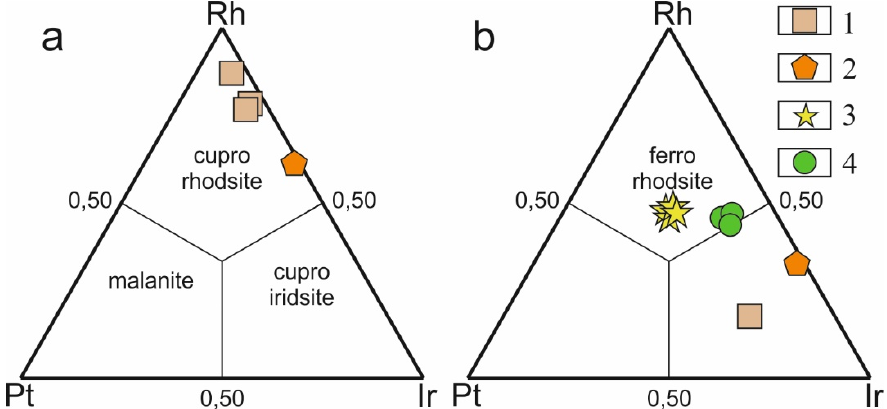
Figure 14. The composition (at. %) of Cu bearing ( a ) and Fe bearing ( b ) Pt-Ir-Rh thiospinels in isoferroplatinum from chromite-platinum ore zones of the Svetloborsky massif (1), the Vershinniy eluvial placer (2), the Travyanistyi proximal placer (3), and the Glubokinskoe distal placer (4).